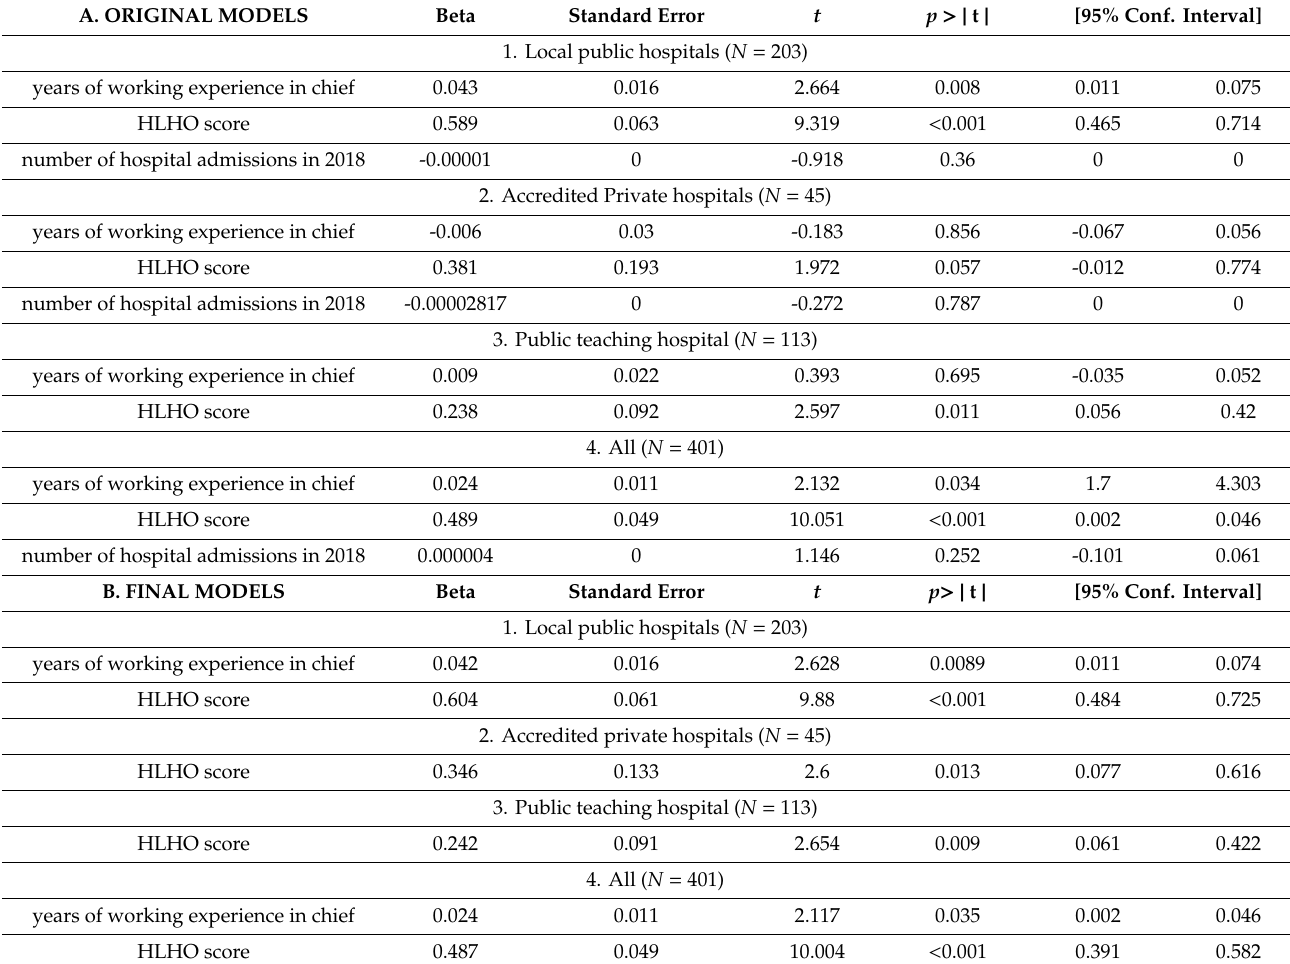
Table 5. Multivariate linear regression analysis: original (A) and final (B) models by type of hospital and in the whole sample. Dependent variable: perceived quality. Data are adjusted for age and